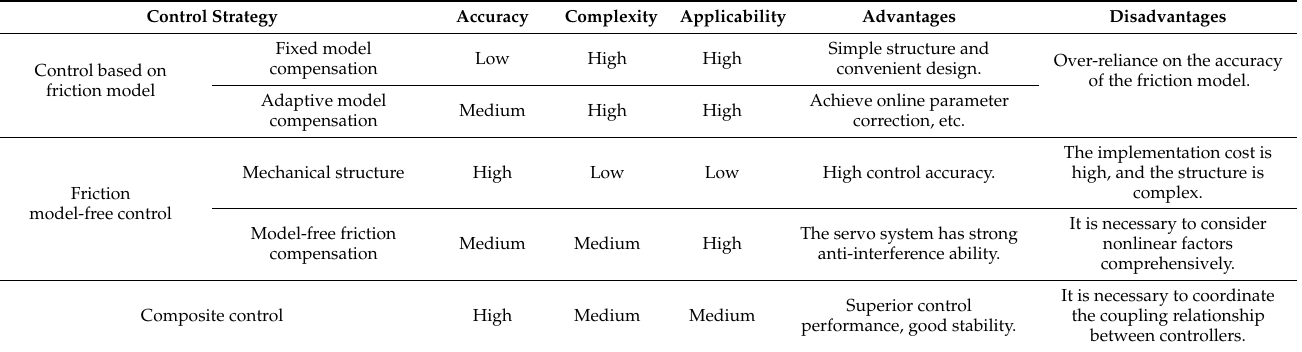
Table 5. Comprehensive analysis of friction control